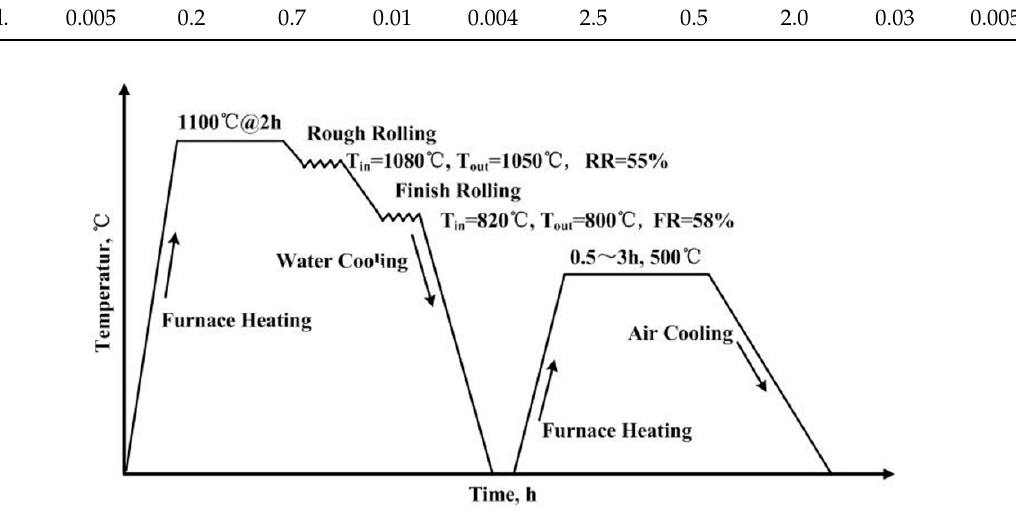
Figure 1 . Schematic of the processing methods used in this study. Figure 1. Schematic of the processing methods used in this